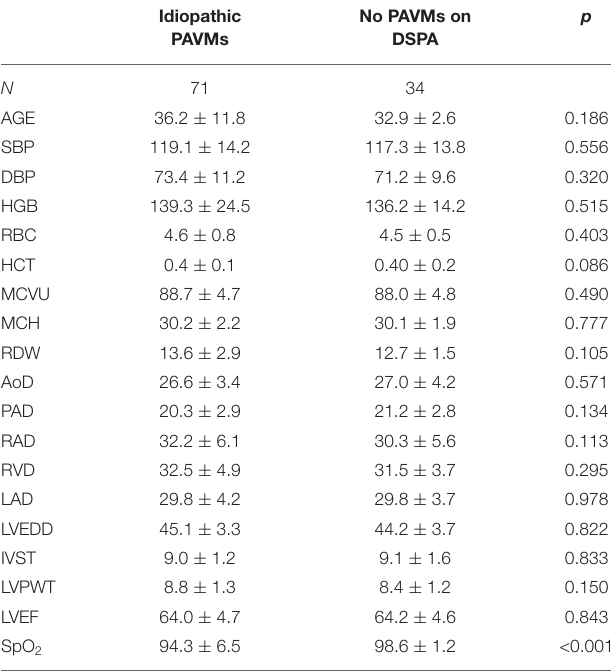
TABLE 2 | The clinical data and echocardiography data of included patients.